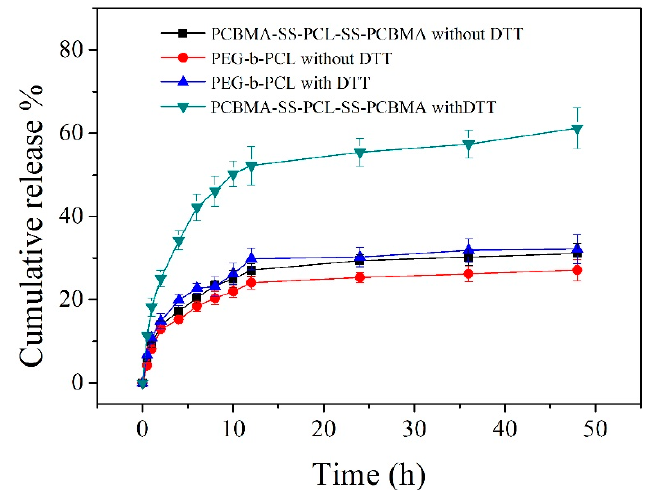
Figure 5. In vitro release profiles of DOX loaded micelles in PBS (0.1 M) at pH 7.4 with or without DTT (10 mg/mL).